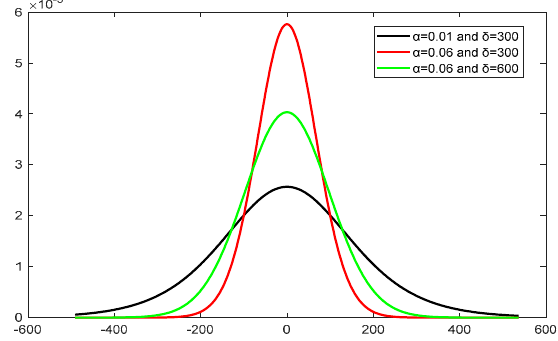
Figure 5. Effect of α and δ on the shape of normal inverse Gaussian of probability density function (NIG pdf).